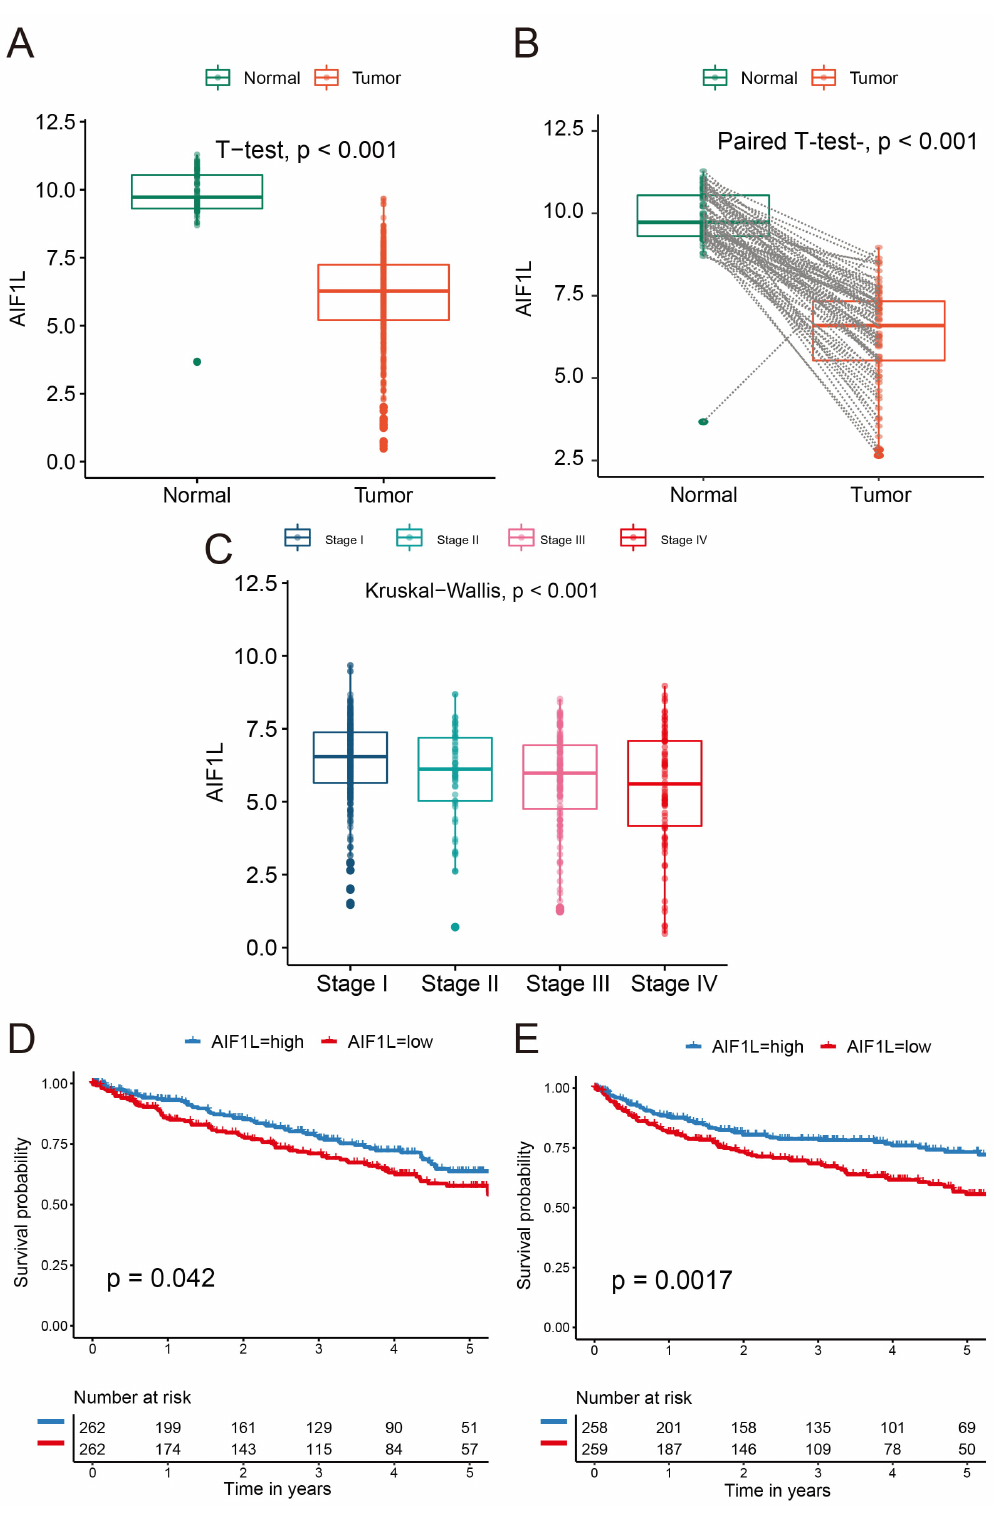
Fig. 1. Correlation of AIF1L expression with malignancy, tumor stage, and prognosis in ccRCC. (A) Student t -test result for the comparison of AIF1L expression between ccRCC and normal kidney samples from the TCGA dataset. (B) Paired t -test result for AIF1L expression between paired ccRCC and normal kidney samples from the TCGA dataset. (C) Kruskal-Wallis test result for AIF1L expression between Stage I, Stage II, Stage III and StageIV tumor samples. (D) Overall survival analysis for ccRCC samples from the TCGA dataset with high or low AIF1L expression. (E) Recurrence-free survival analysis for ccRCC samples from the TCGA dataset with high or low AIF1L